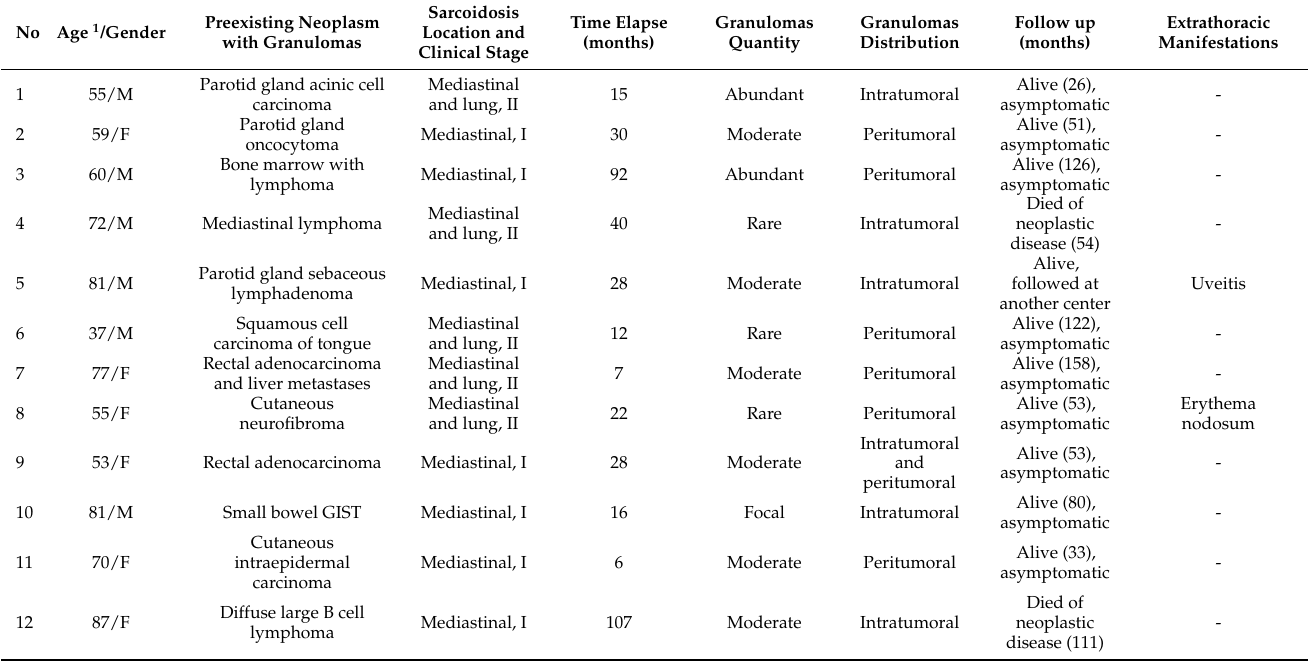
Table 1. Main clinicopathological features of patients with systemic sarcoidosis and preceding